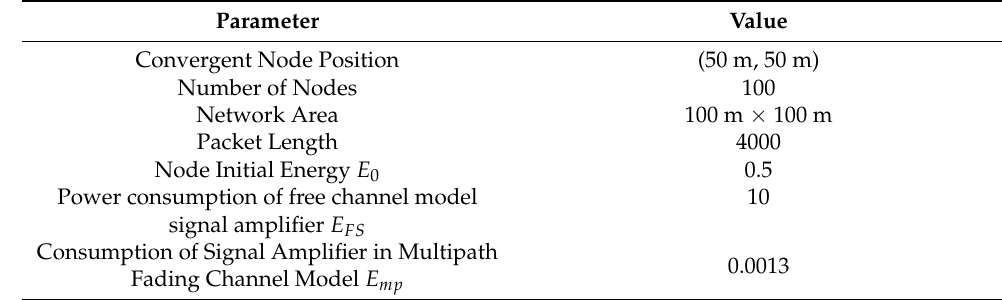
Table 3. Simulation parameter